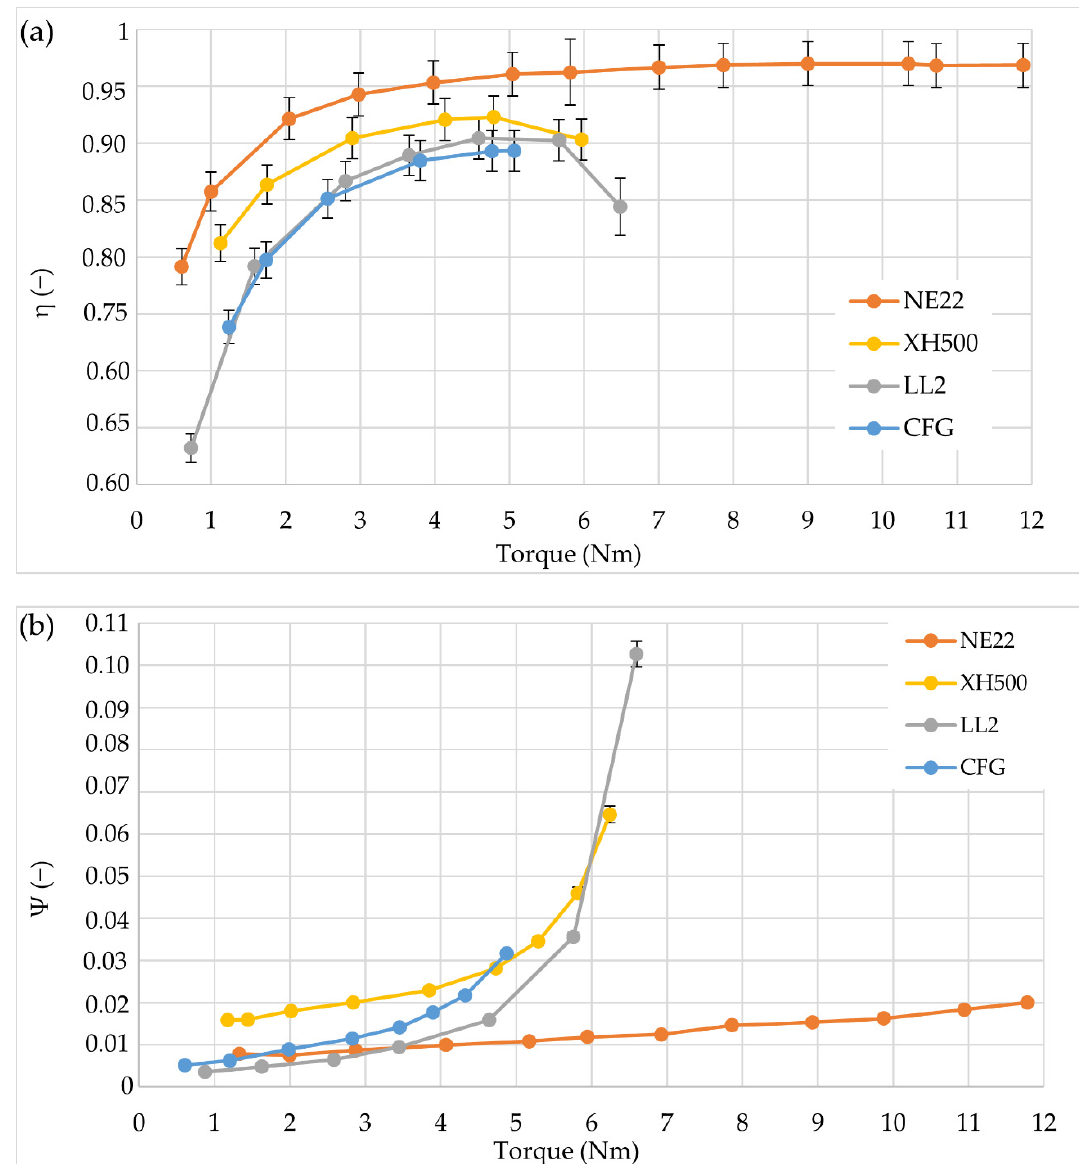
Figure 8. Variation characteristics of ( a ) efficiency as a function of torque at the idler shaft ( b ) belt slippage as a function of torque at the idler shaft at 1500 rpm.